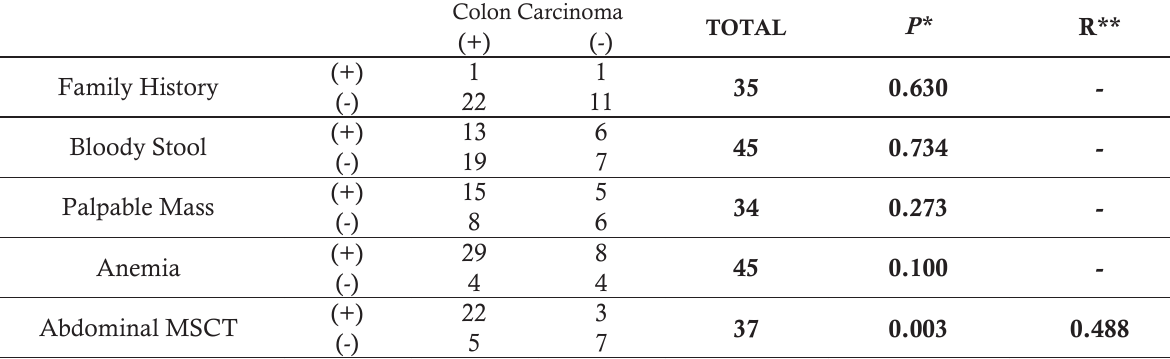
Table 2. Relationships between Variables (family history, bloody stool, palpable mass, anemia, and abdominal MSCT) with Occurrence of Colonic Carcinoma